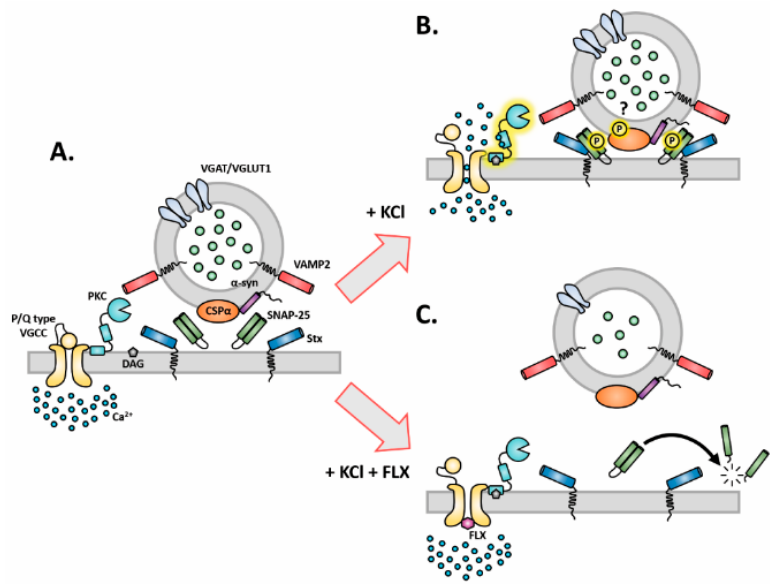
Figure 6. Schematic representation of FLX’s effects on presynapse. ( A ) The presynaptic membrane and synaptic vesicles at rest. ( B ) The activation of PKC upon KCl stimulation and its possible effects on synaptic machinery proteins such as cysteine string protein alpha (CSP α ) and SNAP-25. ( C ) The impact of FLX on SNAP-25 through PKC. FLX: fluoxetine, CSP α : cysteine string protein alpha, α -syn: alpha-synuclein, SNAP-25: synaptosomal nerve-associated protein 25, PKC: protein kinase C, Stx: syntaxin, VAMP2: vesicle-associated membrane protein 2, VLUT1: vesicular glutamate transporter 1, VGAT: vesicular GABA transporter, DAG: diacyglycerol, VGCC: voltage-gated calcium channel, Ca 2+ : calcium.